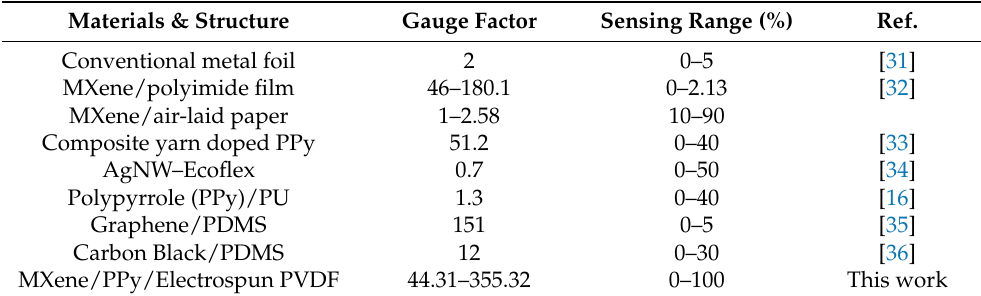
Table 1. Comparison of different material fabricated strain sensors.